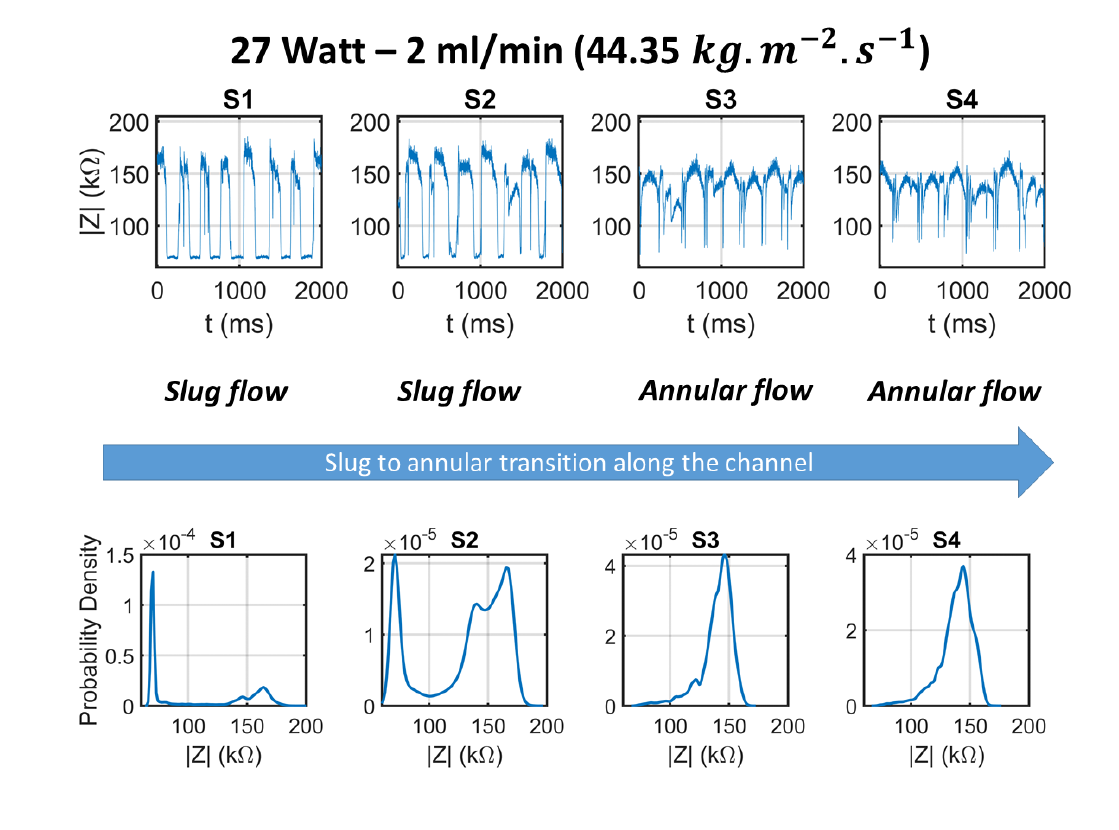
Figure 17. Change of the signal and flow regime along the channel in four sensor